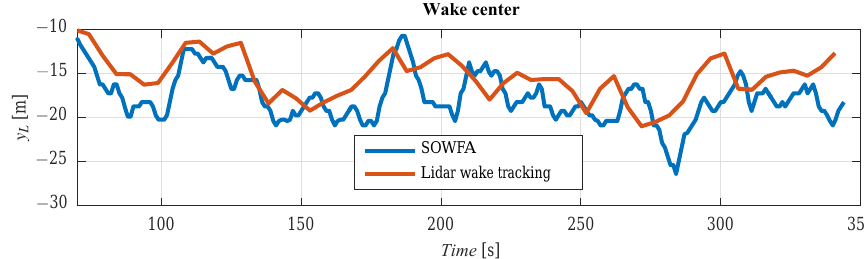
Figure 10. Comparison between the wake center estimation (see Eq. 1) and the lidar-based wake-tracking method.